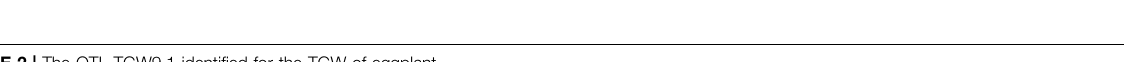
TABLE 2 | The QTL TGW9.1 identi fi ed for the TGW of eggplant. QTL Chr Physical Genetic position (cM) Bin mark LOD PVE% Additive Dominant distance interval (bp) number TGW9.1 9 26099638 – 2,6772016 60.26